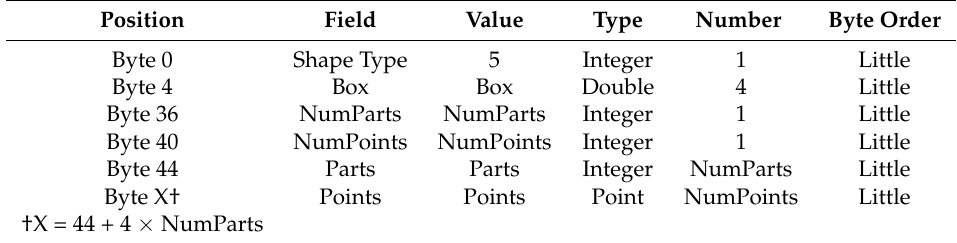
Table 2. Description on polygon record contents. The fields for a polygon type are box, numParts, numPoints, parts, and points. Box means the bounding box for the polygon stored in the order Xmin, Ymin, Xmax, Ymax. The number of closed curves in the polygon is described by NumParts. NumPoints is the total number of points for all closed curves. parts means an array of length numParts. For each closed curve, the index of its first point stored in the points array. Points are array of length numPoints. The points for each closed curve in the polygon are stored end to